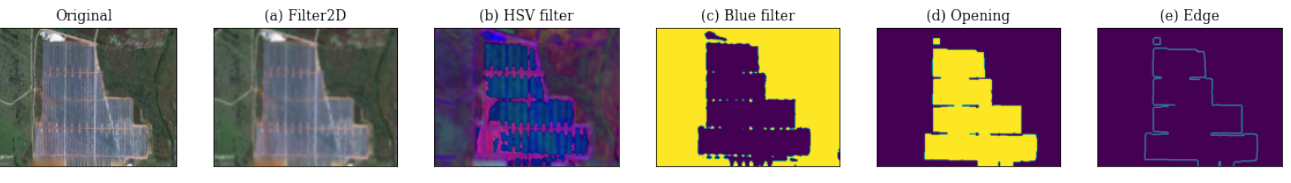
Figure 4. Steps of boundary extraction by